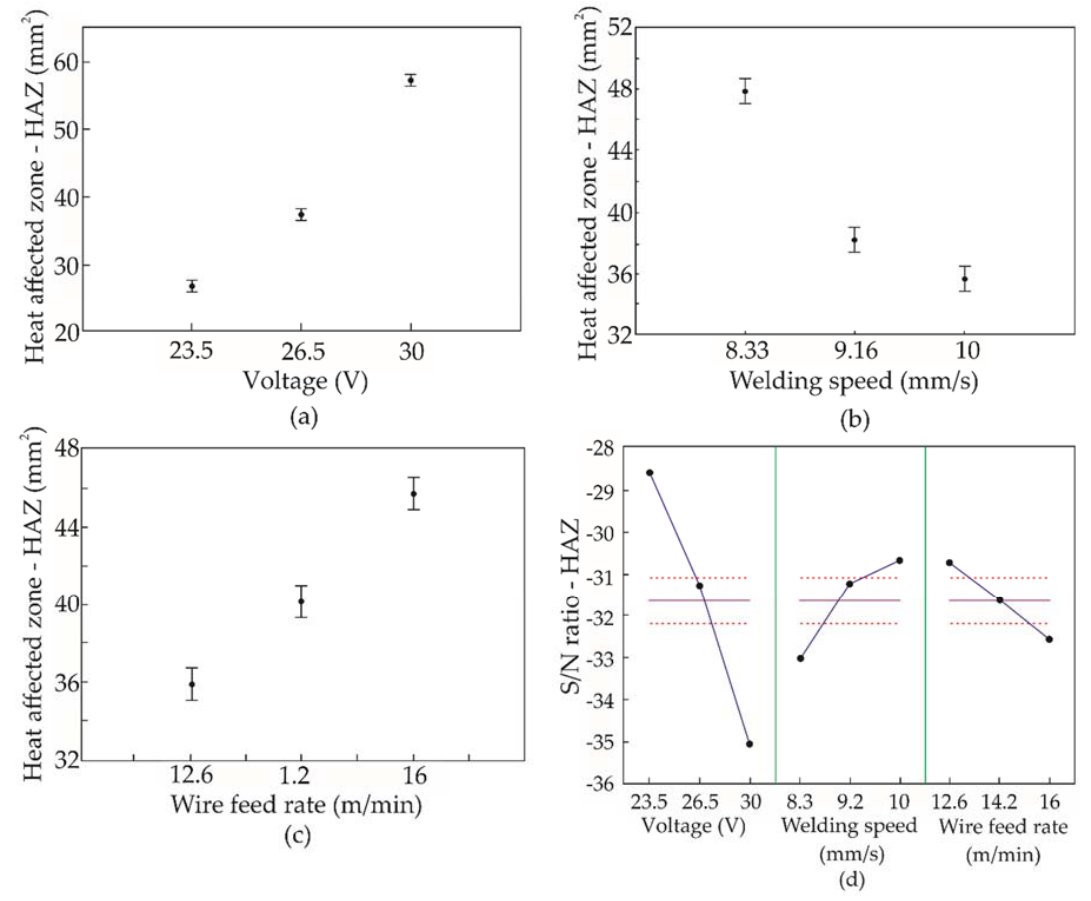
Figure 6. ( a ) HAZ as a function of voltage; ( b ) HAZ as a function of welding speed; ( c ) HAZ as a function of wire feed rate; and ( d ) signal-to-noise ratio (smaller is better) for the HAZ.